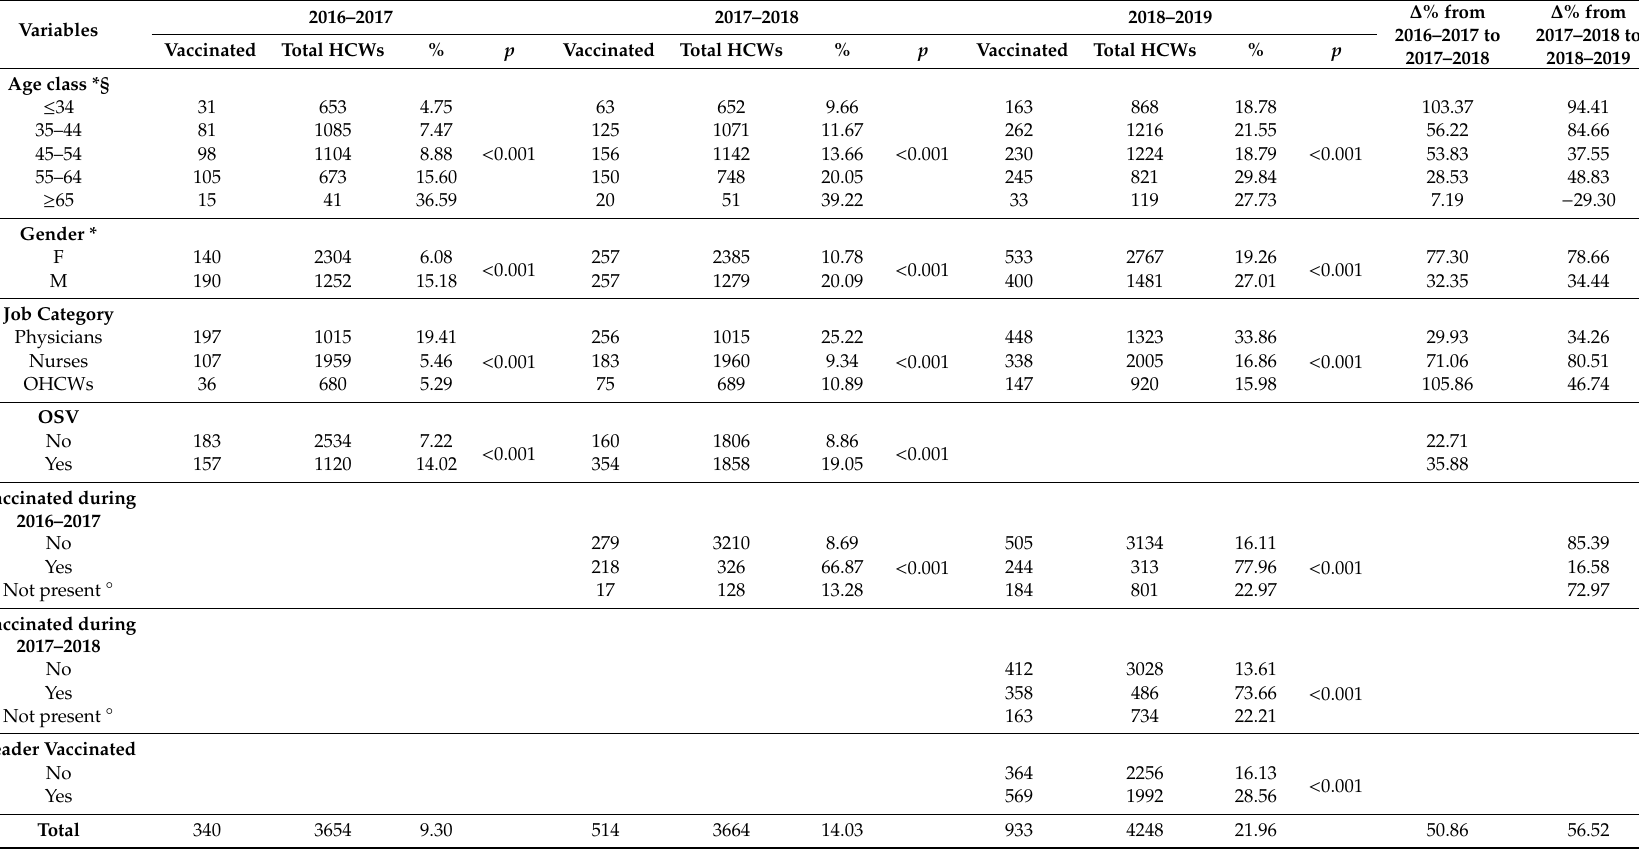
Table 2. Characteristics of the HCWs and univariate analysis for the 2016–2017, 2017–2018 and 2018–2019 flu vaccination campaigns and percentage of increasing